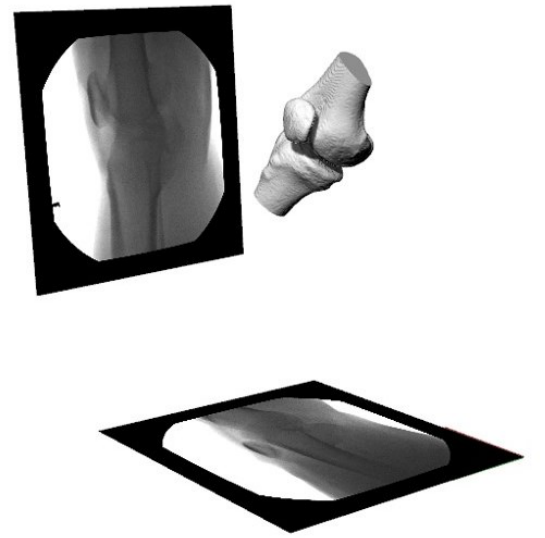
Figure 3. The virtual dual-orthogonal fluoroscopic system duplicates patellofemoral joint motion using a 3D-to-2D registration technique.